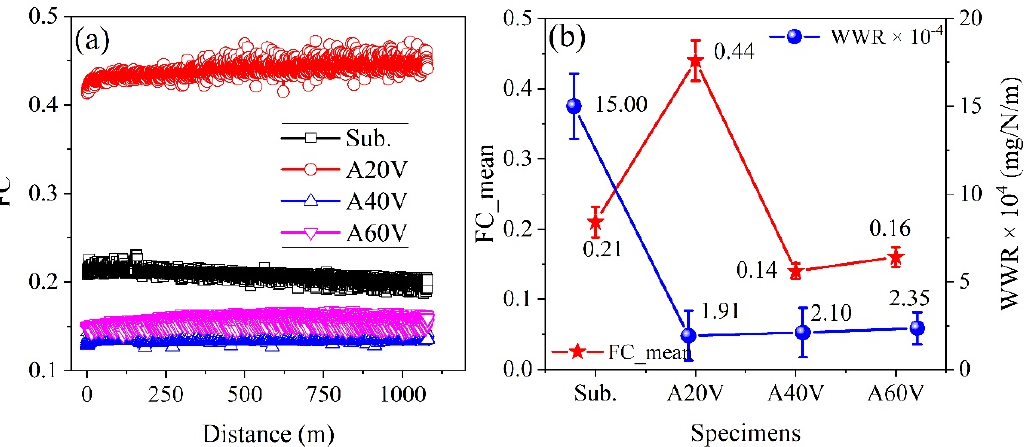
Figure 5. Tribological results: ( a ) friction coefficient vs. distance curves, and ( b ) FC_mean and WWR.